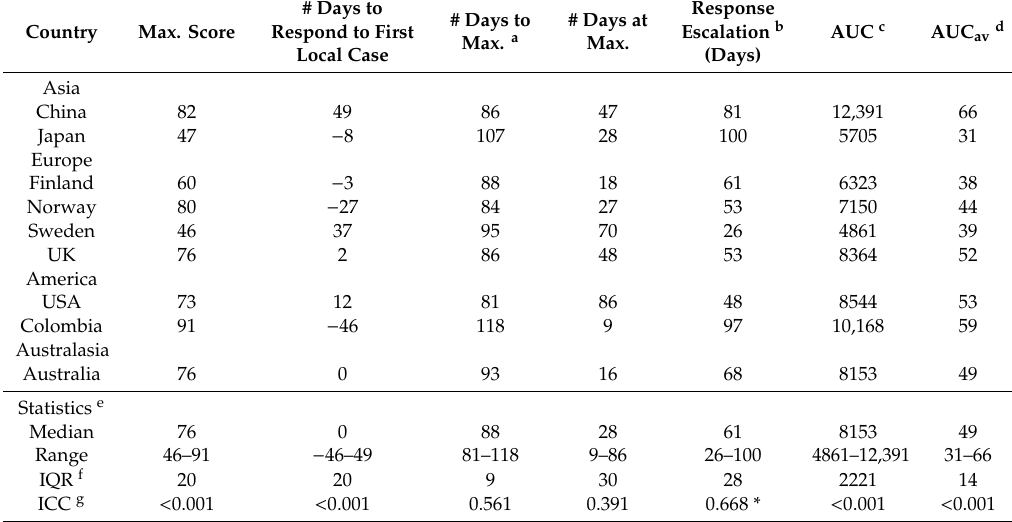
Table 1. Characteristics of Oxford Stringency Index for the focus countries from January to July 2020. Country Max. Score